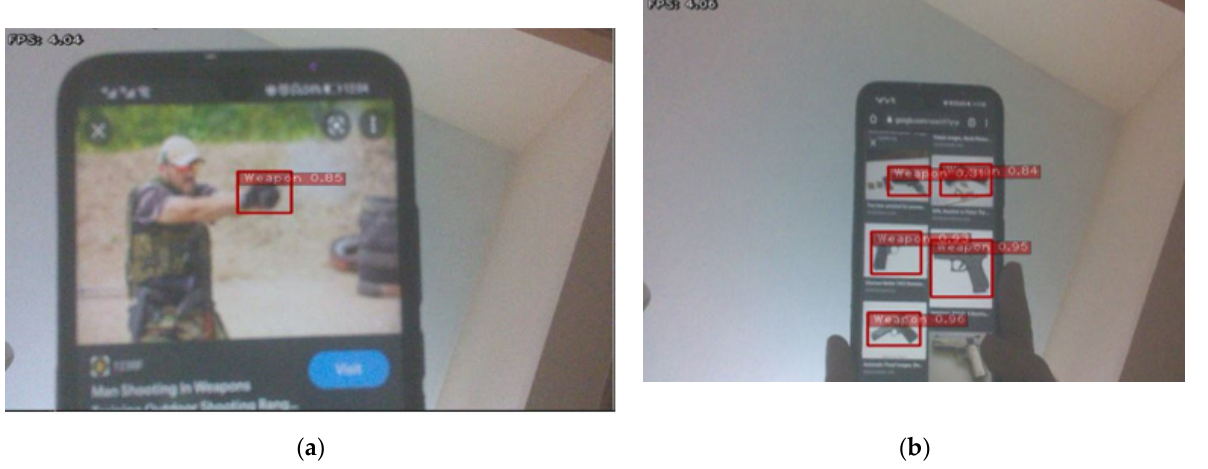
Figure 15. Real-time results on Jetson Nano using PI Camera Scaled-YOLOv4. ( a ) Image with a person holding a weapon and pointing toward the aim with background data. ( b ) Image with a weapon on a surface with no background data at different orientations and angles.